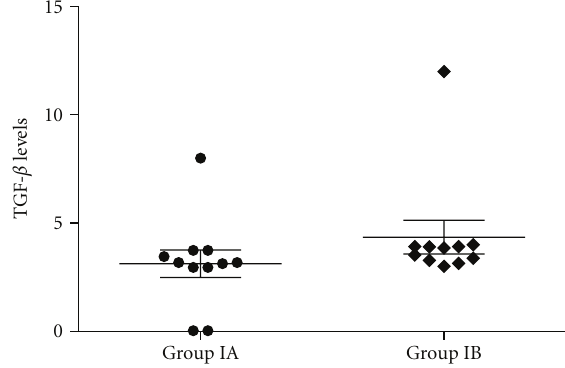
Figure 3: TGF- β levels of severe persistent asthma patients before and 4 months after the anti-IgE therapy ( P = 0 . 013).